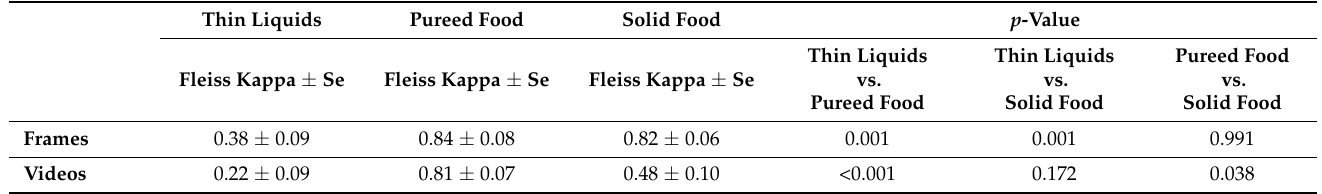
Table 11. Influence of bolus consistency on inter-rater reliability in frames and video ratings across all raters (n = 29) at the first assessment for all